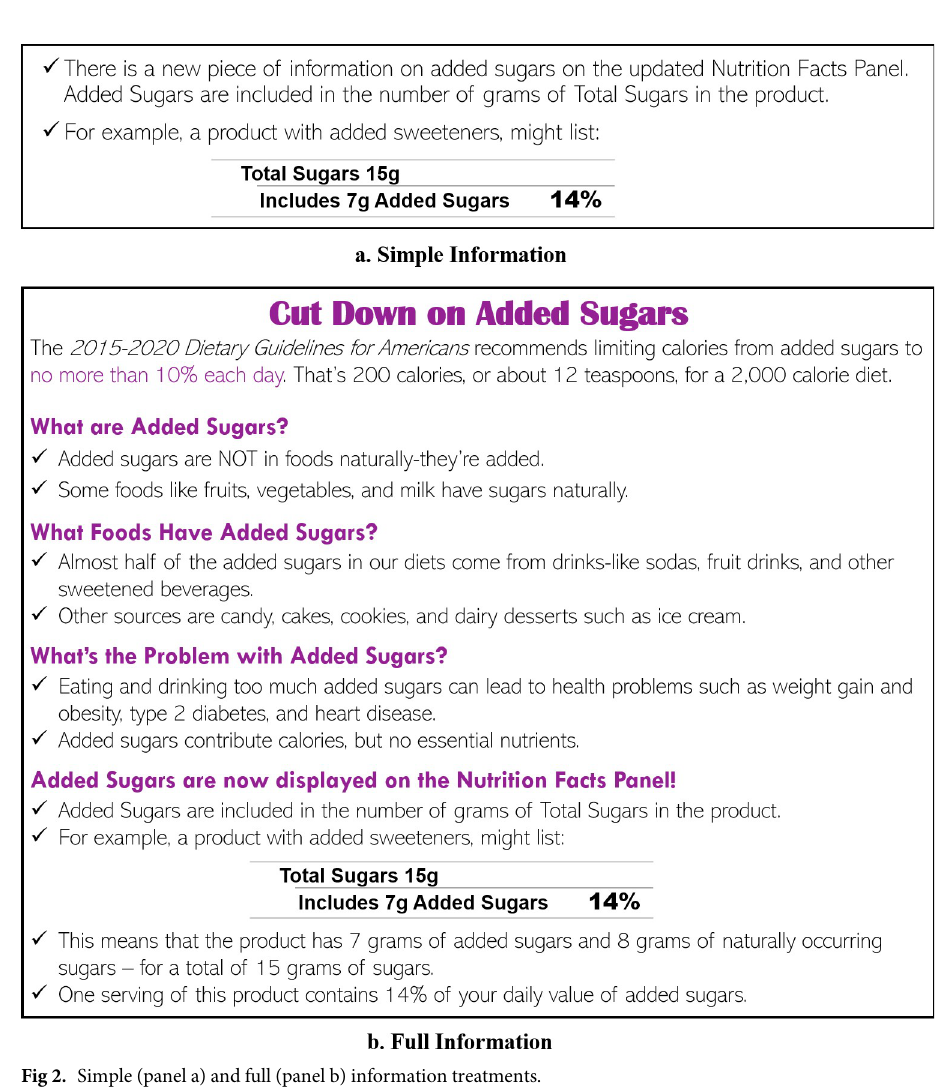
Fig 2. Simple (panel a) and full (panel b) information